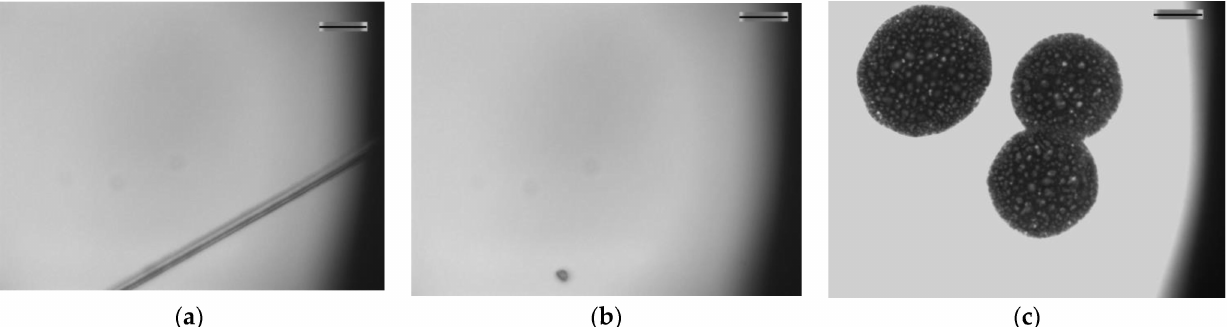
Figure 6. Optical micrographs of the silver mirrors protected with a 4.5 nm layer of SiN x film and taken with 100 × objective: ( a ) non-treated with O 2 plasma (a scratch is used for the focusing purpose only); ( b ) treated with O 2 plasma for 1 min; ( c ) treated with O 2 plasma for 40 min. Black scale bar in top right corner of each image represents 10 microns.